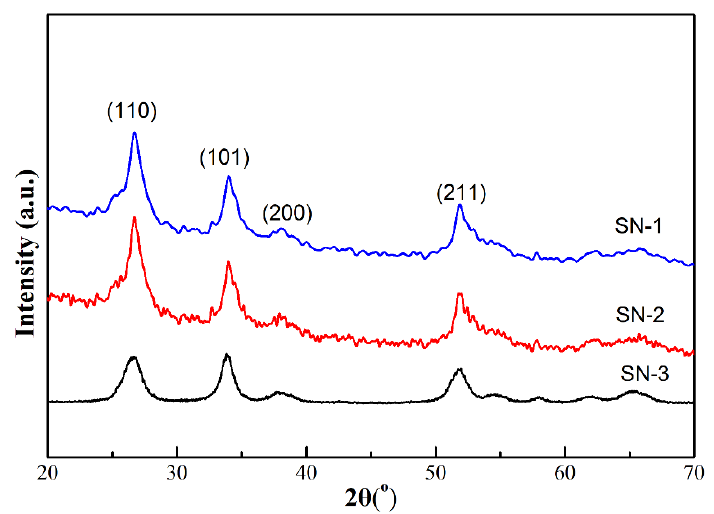
Figure 1. XRD patterns of as-prepared SnO 2 samples (blue: SN-1 sample; red: SN-2 sample; black: SN-3